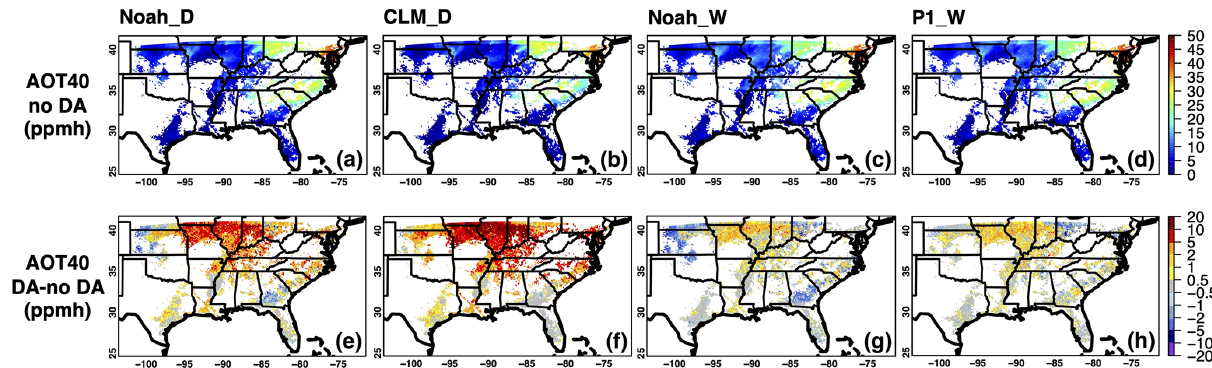
Figure 15. WRF-Chem-based AOT40, derived from the modeled surface O 3 fields during 16–28 August 2016, as well as their responses to the SMAP DA. Panels (a) and (e) , (b) and (f) , (c) and (g) , and (d) and (h) show results derived from the Noah_D, CLM_D, Noah_W, and P1_W cases, respectively, in cropland-dominant model